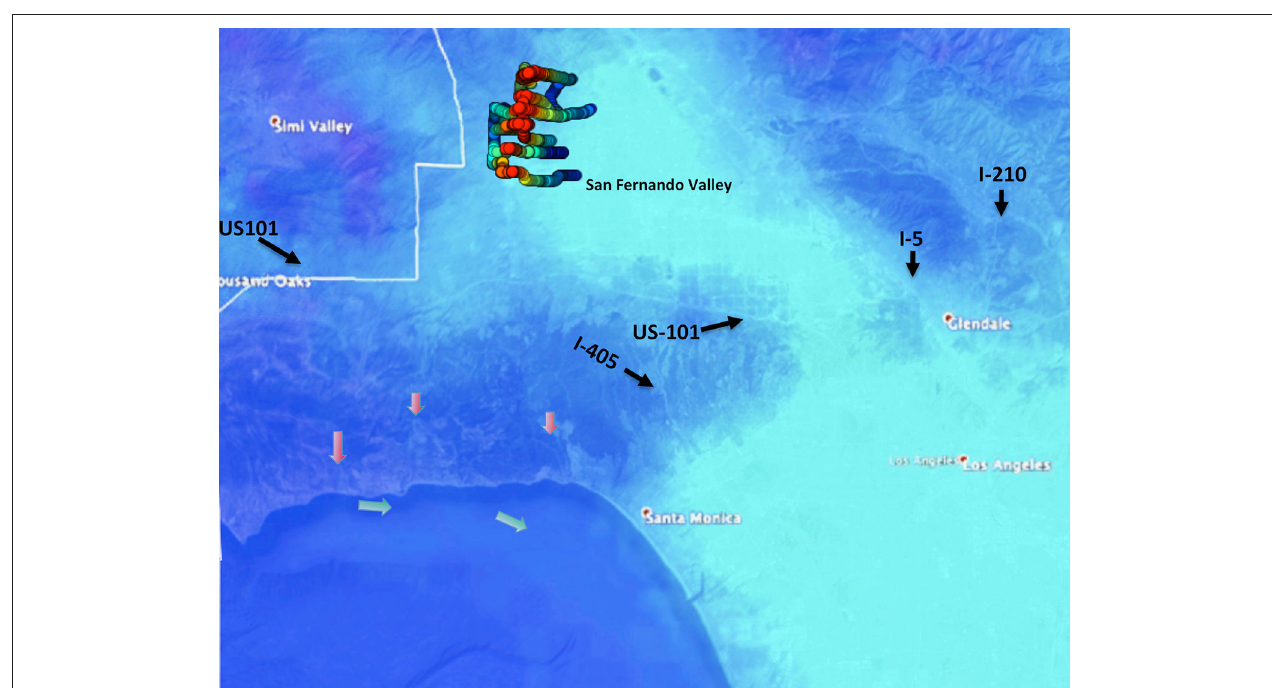
FIGURE 7 | Contrast enhanced to show overall MODIS Aerosol Optical Depth (AOD) structure for 13 November 2015 for northwest Los Angeles and the San Fernando Valley. AOD contrast highly saturated to bring out spatial structure in passes and over oceans. Pale green arrows lie immediately north of the offshore AOD structure, which exhibits an east-west orientation and is shown to illustrate airflows. Major traffic arteries through mountain passes are labeled with relevant highway and black arrows. Red arrows shows three different plume outflows, the easternmost corresponding to downwind of the Aliso Canyon leak plume. Methane (CH 4 ) data shown for spatial reference. See Figure 3 for CH 4 data and CH 4 data key. See Figure 6 for AOD data with AOD data